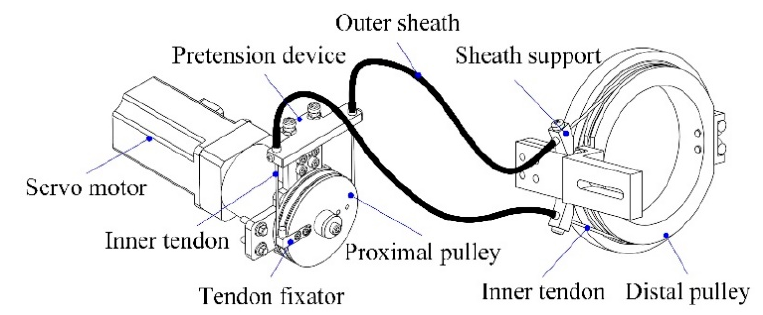
Figure 1. Architecture and major components of the upper extremity rehabilitation exoskeleton. ( a ) Virtual prototype model. ( b ) Real-life picture of exoskeleton.